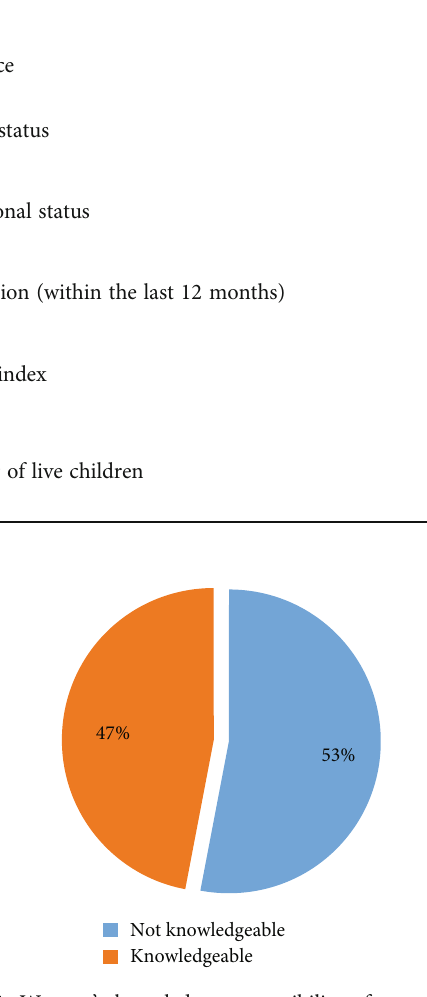
Figure 1: Women ’ s knowledge on possibility of pregnancy after birth but before the resumption of menstruation using Ethiopian Demographic Health Survey 2016 analysis.